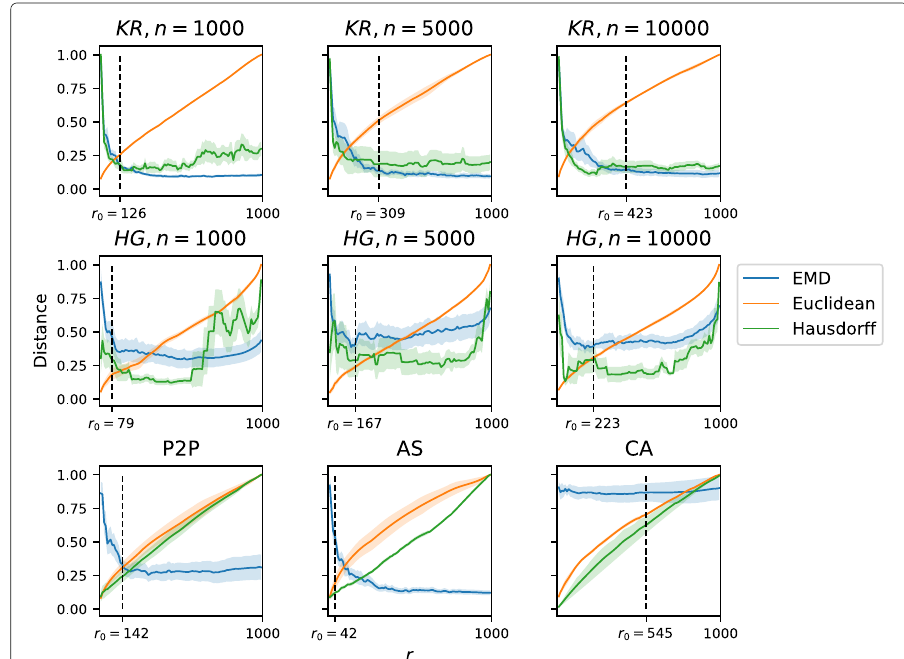
Fig. 5 Different ways of comparing non-backtracking eigenvalues. We compare the non-backtracking eigenvalues of two different graphs of the same data set using three different methods: EMD , Euclidean , Hausdorff (see “Choice of distance and dependence on r ” section), using the r eigenvalues largest in magnitude. We also show the median value r 0 after which the eigenvalues have magnitude less than Shaded areas show standard deviation. First two rows show results for random graphs of models KR and HG for different number of nodes n . Bottom row shows results for real data sets. See Table 2 for description of data sets. Values have been normalized by the largest observed distance with each different distance method for ease of